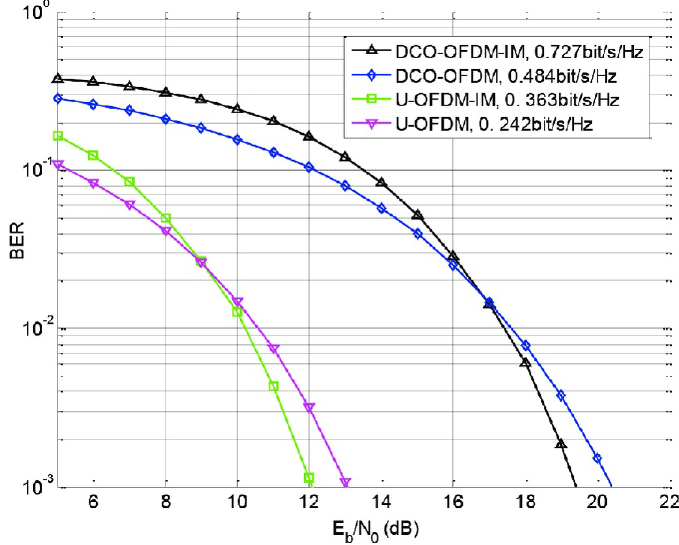
Fig. 3 OFDM optical domain signal power comparison diagram.